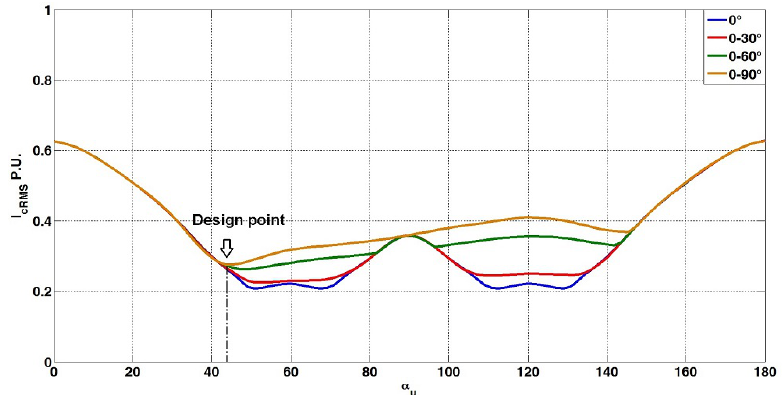
Figure 13. Simulated results: triple-3-phase phase machine: I C The different curves represent the maximum I C